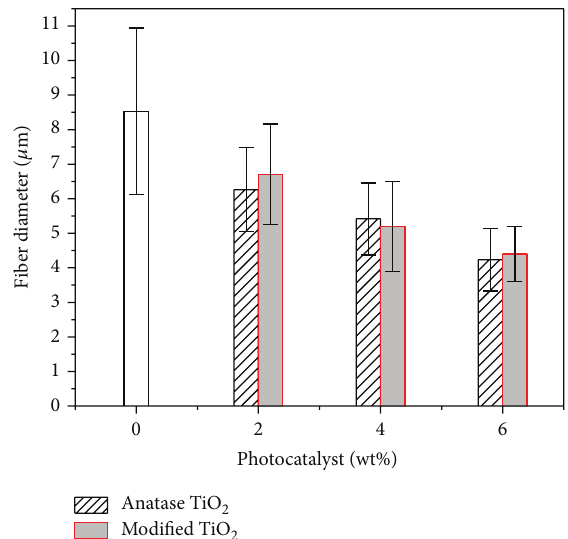
Figure 5: Diameter of resulting electrospun fibers as a function of the relative concentration of additives.